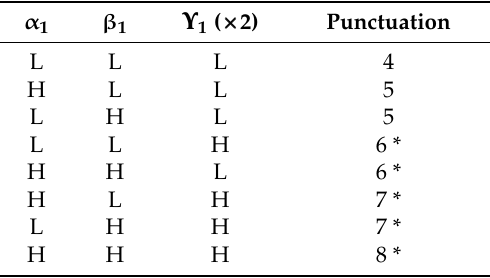
Table 1. Risk measure using the LISA classification. α 1 β 1